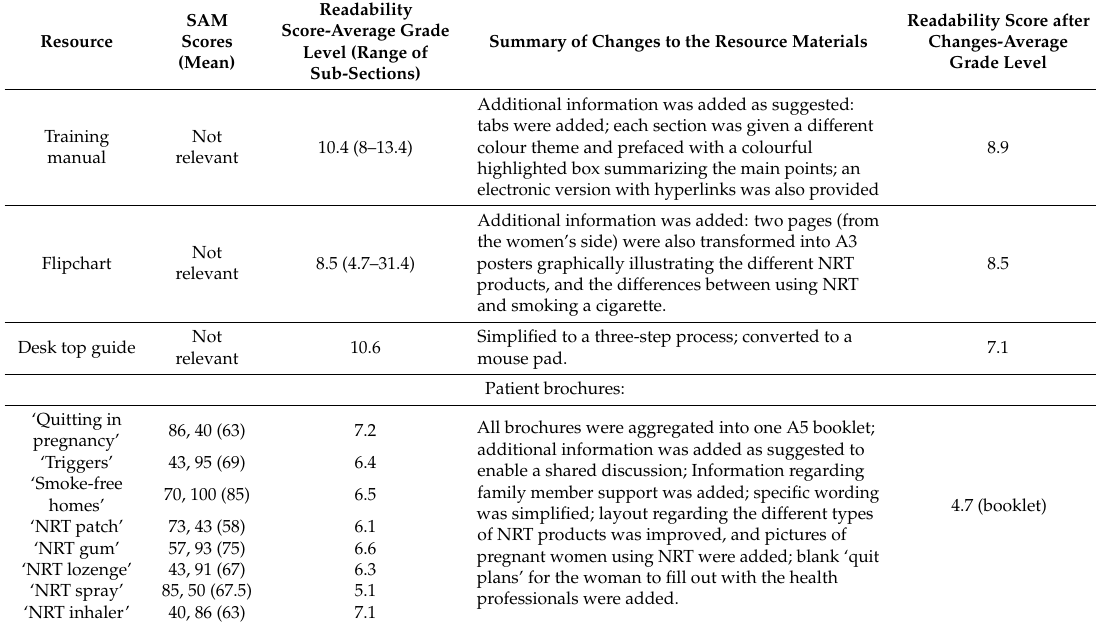
Table 1. Summary of Suitability of Resources (SAM) and Readability scores (before and after changes), and changes that were done to the educational resources